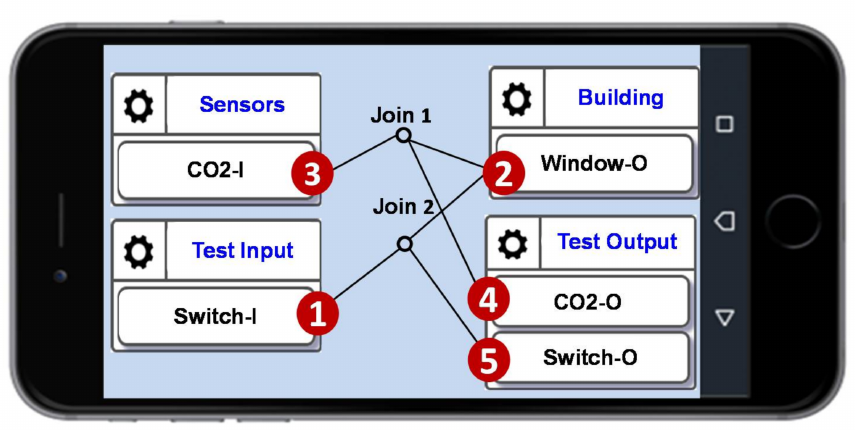
Figure 17. Mutual-test configuration for a CO 2 sensor and an electric window.